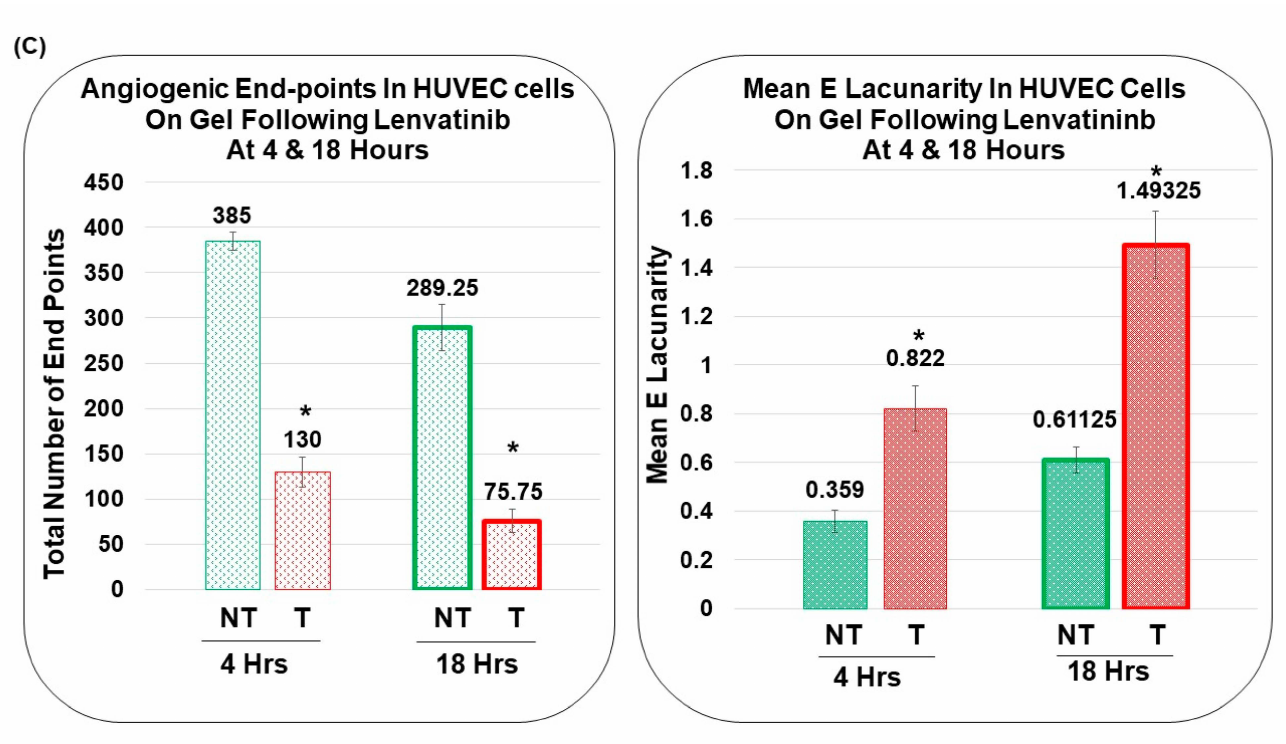
Figure 6. Effect of Lenvatinib on cord formation of HUVEC cells on − gel: The effect of lenvatinib on the HUVEC cell cord formation on matrigel is tested at 0 h, 4 h, and 18 h. The angiogenic score of HUVEC cell on-gel cord formation at 0 h and 18 h ( A ) is measured by the number of polygons and junctions. Similarly, the effect of lenvatinib on the angiogenic score of HUVEC cell on-gel cord formation at 4 h and 18 h are measured by the number of polygons and junctions ( B ) as well as measuring angiogenic endpoints and mean E lacunarity ( C ). Matrigel tube formation assay of HUVECs cultured in control medium (green) or in the presence of 1 microM of lenvatinib (red) for 4 h (standard border of the width of bars) and 18 h (thicker border of the width of bars). Angiogenic Endpoints (total number) (represented in Divot bars) and the mean E lacunarity (represented in 40% filled bars) were detected with the AngioTool software (https://ccrod.cancer.gov/confluence/display/ ROB2/Home; [accessed on 9 August 2022]). Bars represent the mean, and standard deviation of the mean; * p values are indicated for significant changes. Please note that the angiogenic endpoints in non-treated HUVEC cells showed a decreasing trend at 18 h as compared to 4 h. This is because the cord formation was dissolved and non-detected at later hours, after 24 h. However, the lacunarity of non-treated HUVEC cells showed an increasing trend at 18 h as compared to 4 h because the cells started to coalesce/aggregate as the cord formation started to dissolve. However, the total number of endpoints significantly decreased, and the lacunarity increased significantly following lenvatinib as compared to the respective controls at both 4 and 18 h, which matched with the pattern of decrease of the number of polygons and the junctions of the complete polygons. Being an automated assessment, AngioTool reduces subjectivity and the likelihood of human error and streamlines the analysis of features as compared to the manual evaluation, such as counting the number of complete polygons, endpoints, or numbers of junctions per